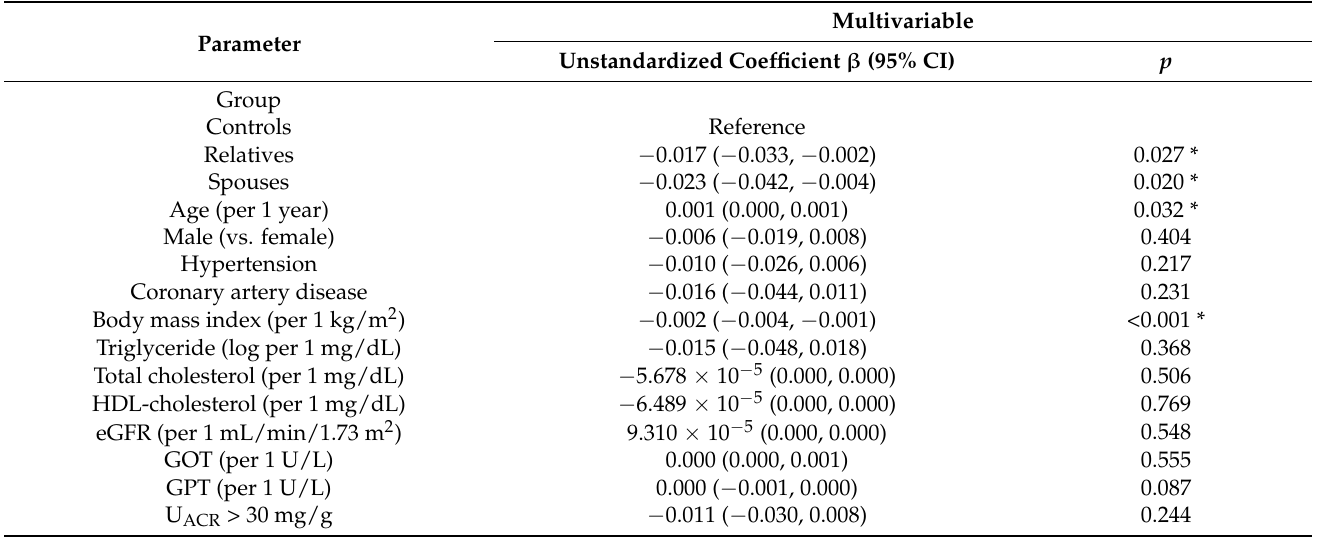
Table 5. Determinants of QUICKI using multivariable linear regression